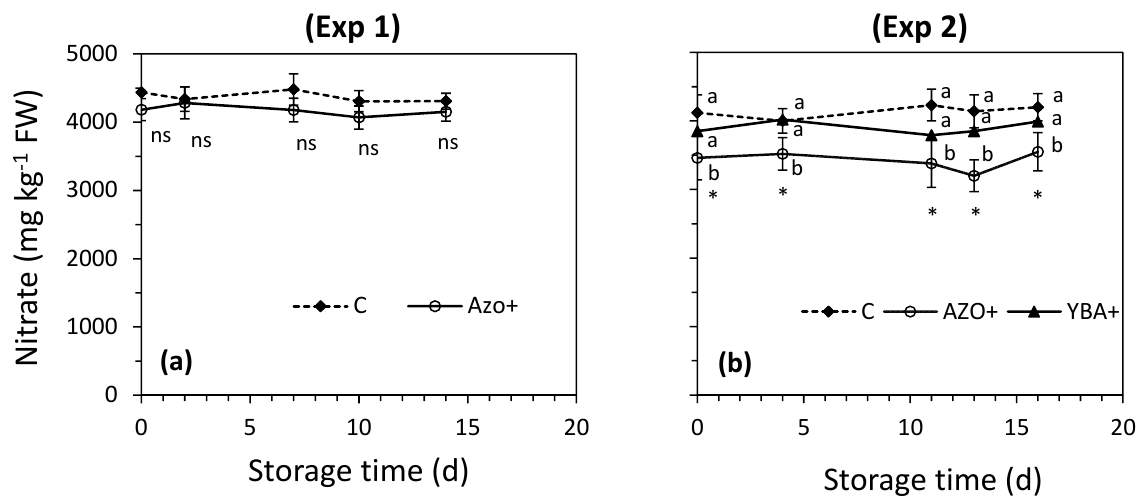
Figure 5. Trend of the nitrate content during the storage of the wild rocket treated with Azoxystrobin (Azo +) at preharvest in Exp 1 ( a ), and with Azoxystrobin or an algae-based biostimulant (YBA+) in Exp 2 ( b ), and of that relating to the untreated control (C). FW = fresh weight. Vertical bars indicate SD (n =3). ns, * indicate F test not significant, significant at P ≤ 0.05 and significant at P ≤ 0.01, respectively. Separation of mean within the days from the start of storage by SNK test (Taiz, L.; Zeiger, E. Plant Physiology ; The Benjamin/Cummings Publishing Company, Inc., 2002; 675p = 0.05). Different lower case letter denotes significant differences.